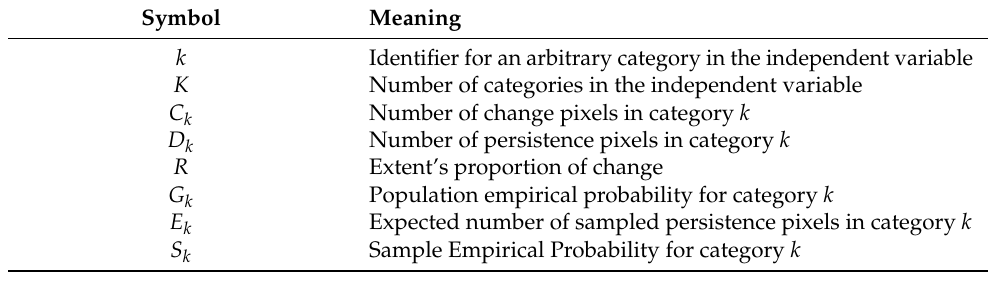
Table 2. Mathematical notation for Equations